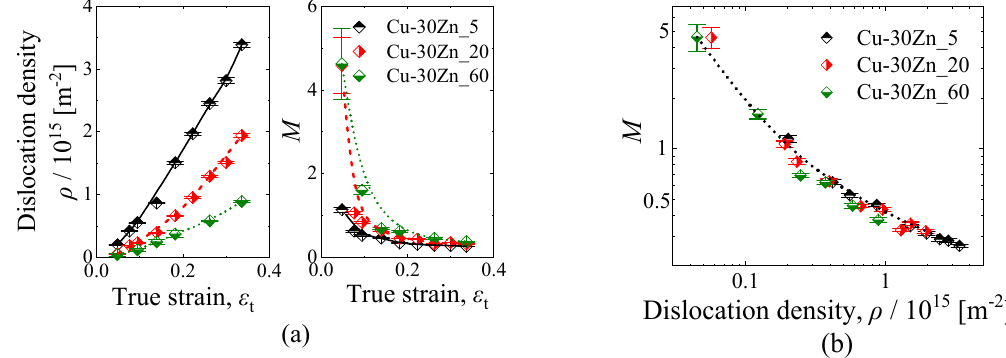
Figure 11. ( a ) Variations of dislocation density and M with respect to true strain [22]; ( b ) M as a function of dislocation density.